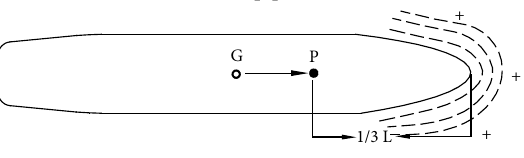
Fig. 11. The location of the pivot point when the ship moves ahead